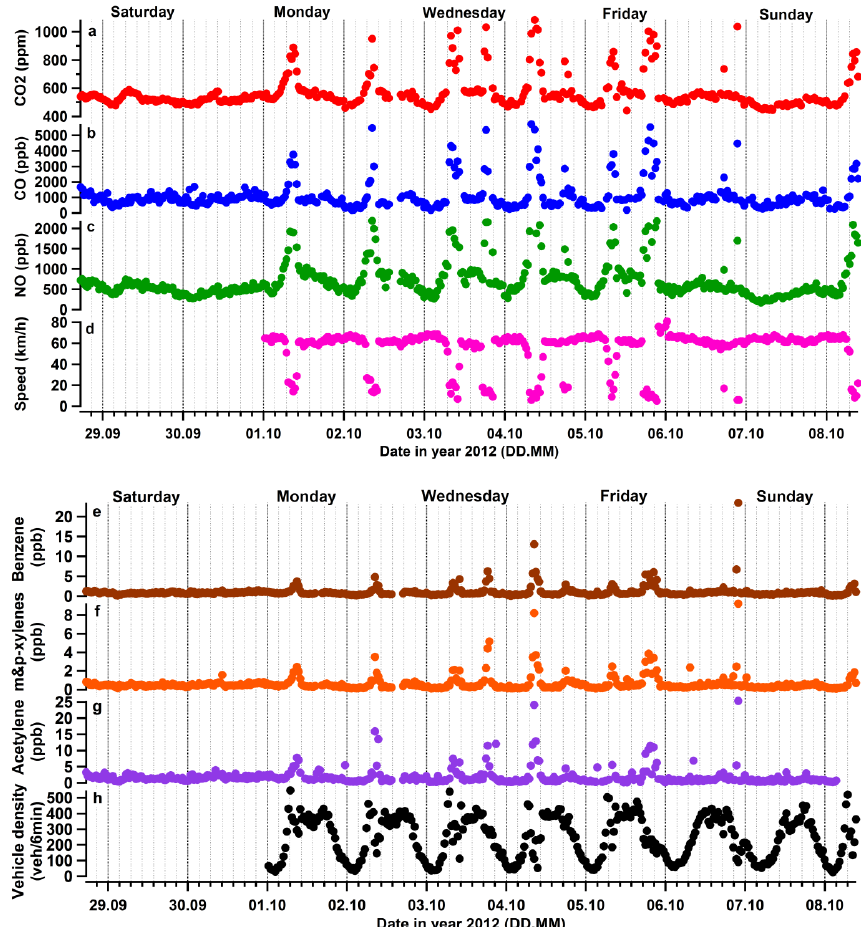
Figure 1. (a-c) and (e-g) Temporal variation of the mole fraction of the selected compound during the whole tunnel campaign. (d) Average speed. (h) Vehicle density. Time is given in local (UTC + 2h). Minor ticks on the horizontal axis are distributed every four hours.